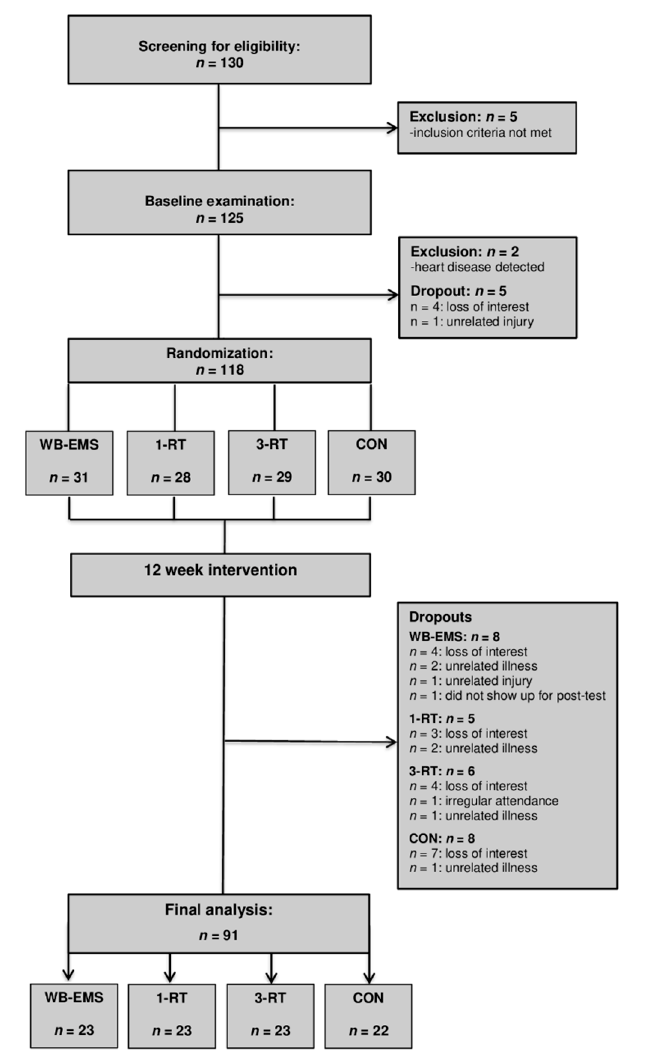
Figure 1. Study flow chart. WB-EMS = whole-body electromyostimulation group, 1-RT = 1-set resistance training group, 3-RT = 3-set resistance training group, CON = control group. Table 2. Daily nutritional intakes pre-intervention and during the last week of intervention.